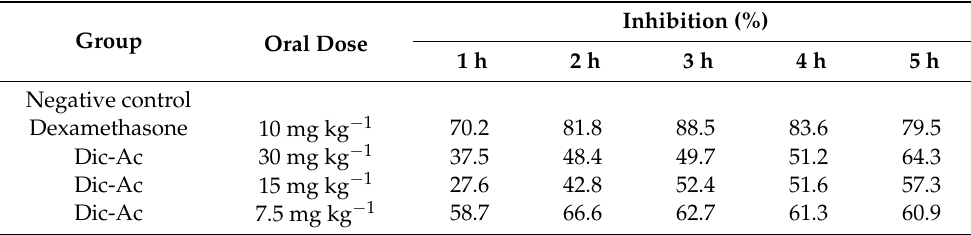
Table 5. Inhibition of carrageenan-induced paw edema in mice from control groups and treated with the Dic-Ac.